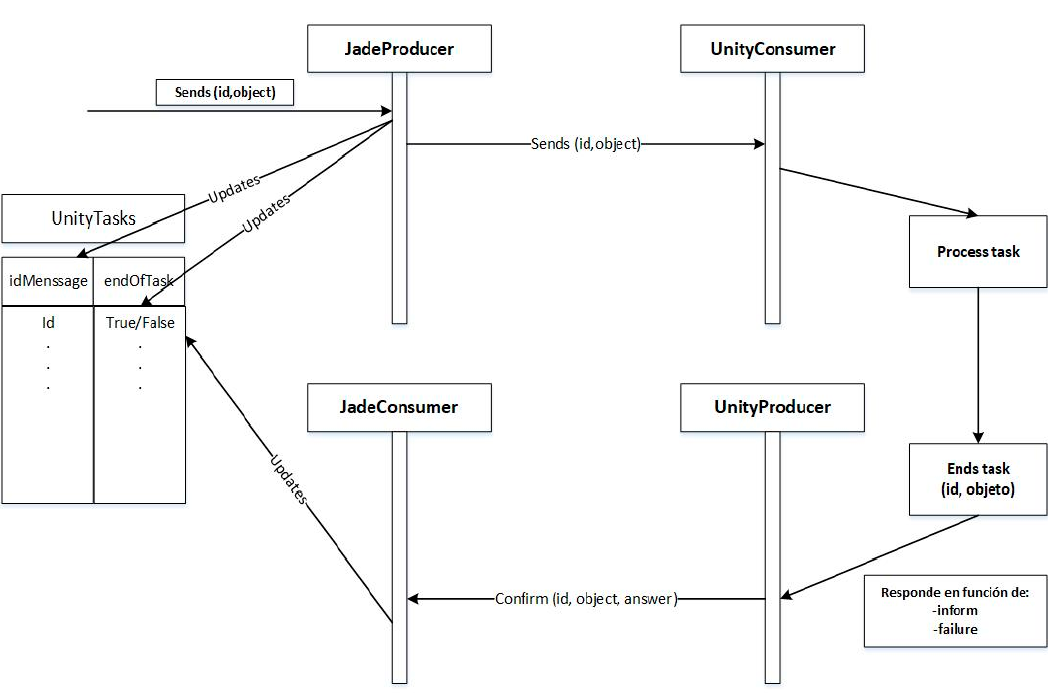
Figure 7. Java Agent Development Environment (JADE)-Unity communication.